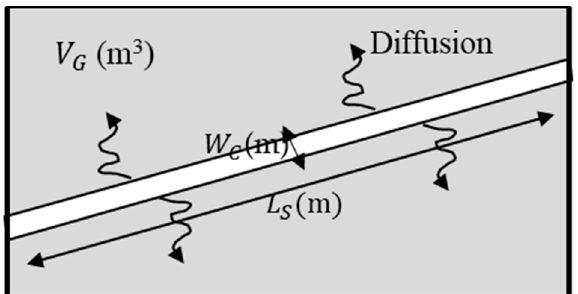
Figure 5. Geometry of crack-grid transfer for a single grid cell with volume V G (m 3 ) intersected by a crack of width W C (m) and segment length L S (m).